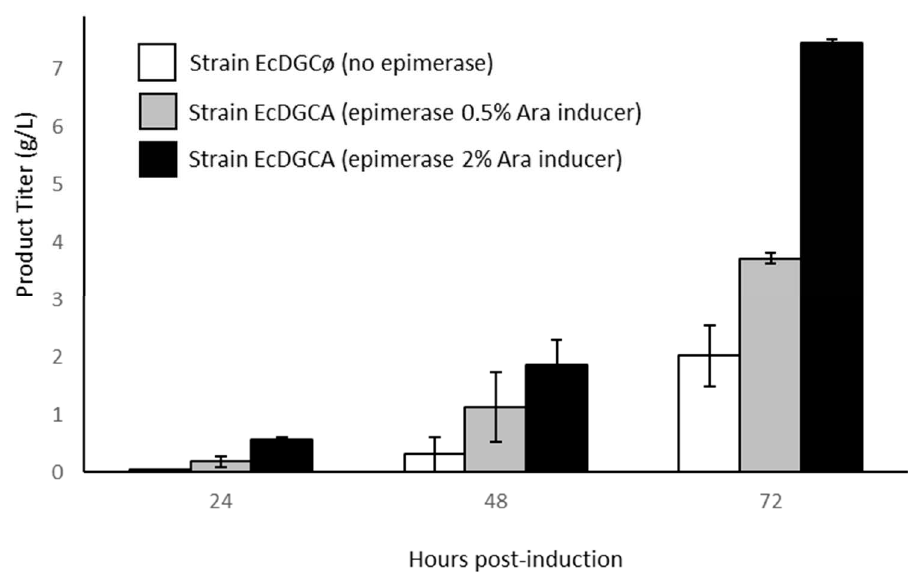
Figure 2. Production of recombinant polysaccharide during growth of engineered strains cultivated in bioreactor. Titer is calculated on the basis of the uronic acid assay. Error bars represent standard deviation of two independent cultures.